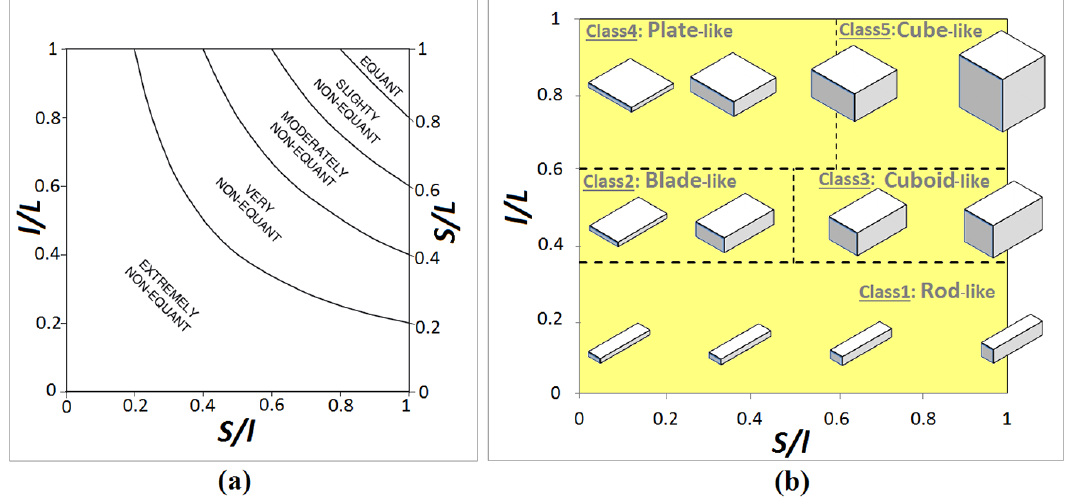
Figure 2. Pore shape classification for equancy based on the S/L ratio (a) ; classes of pore-shape-like artificial objects (b) plotted on a Zingg diagram (modified from Blott and Pye, 2008; Soete et al.,